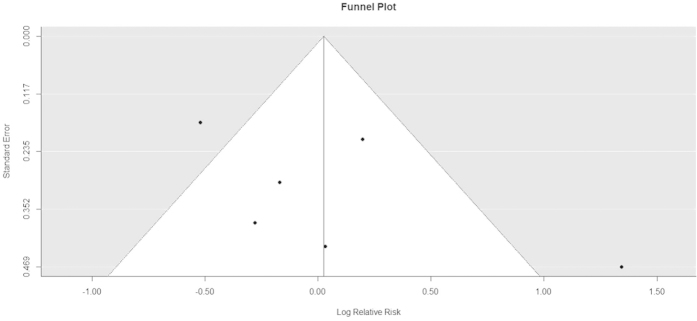
Funnel plot of risk ratios of legumain overexpression in well-differentiated vs moderate–poorly differentiated tumor groups.